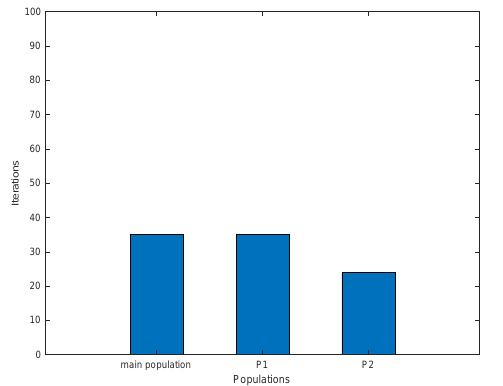
Figure 18: The figure displays the mean and the standard deviation of the average of iteration of matching to find the target object for the robot population over the 106 test images.